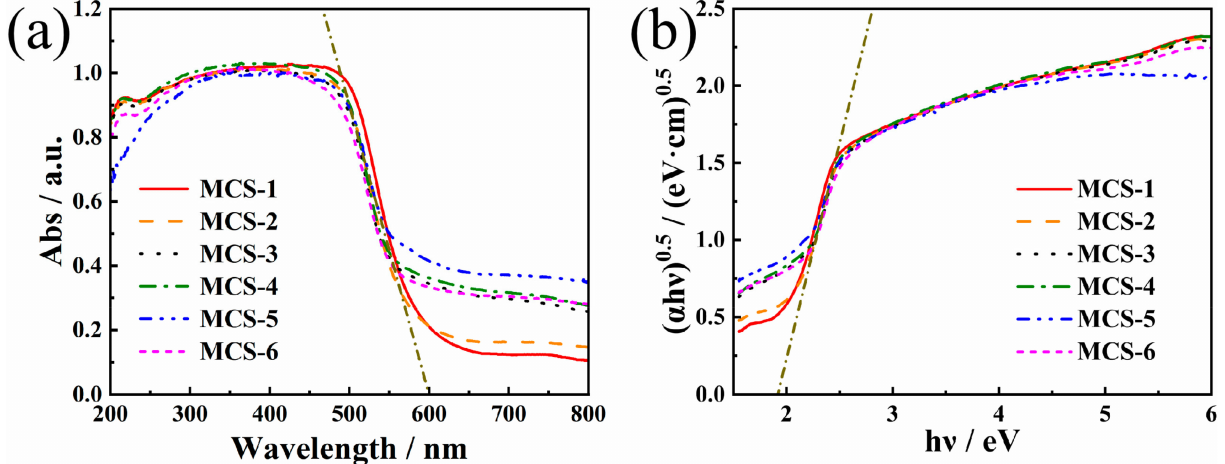
Figure 6. ( a ) UV-vis diffuse reflectance spectra of the MCS samples with a absorption edge located around 600 nm. ( b ) ( α h Table 3. Visible light absorption performance (600–800 nm). Table 3. Visible light absorption performance (600–800 nm). Table 3. Visible light absorption performance (600–800 nm).